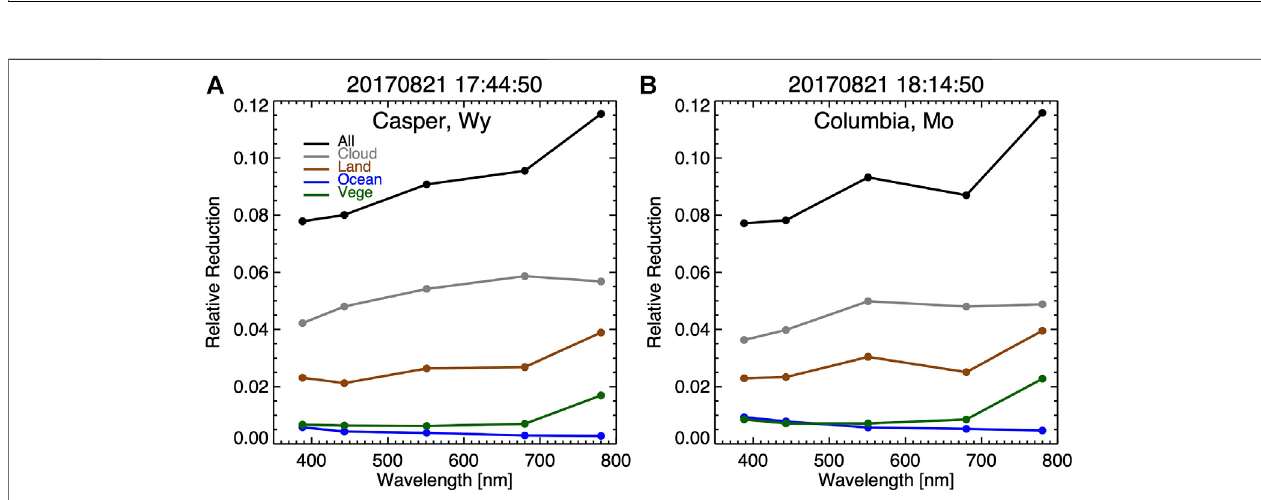
FIGURE 12 | Relative disk average re fl ectance reduction with contributions from different re fl ector types for 2017 eclipse when the center of the Moon ’ s shadow was in (A) Casper, Wyoming, (B) Columbia, Missouri.